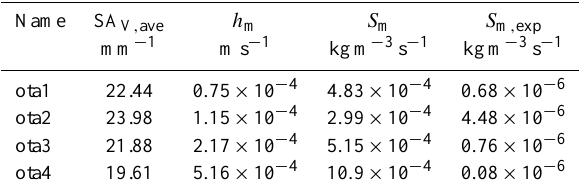
Table 2. Estimated sublimation rate S m using the mass transfer co- efficient h m determined by Neumann et al. (2009) and the corre- sponding average surface area per volume SA V , ave . S m can be com- pared with the measured sublimation rate of the experiment S m , exp (Eq.